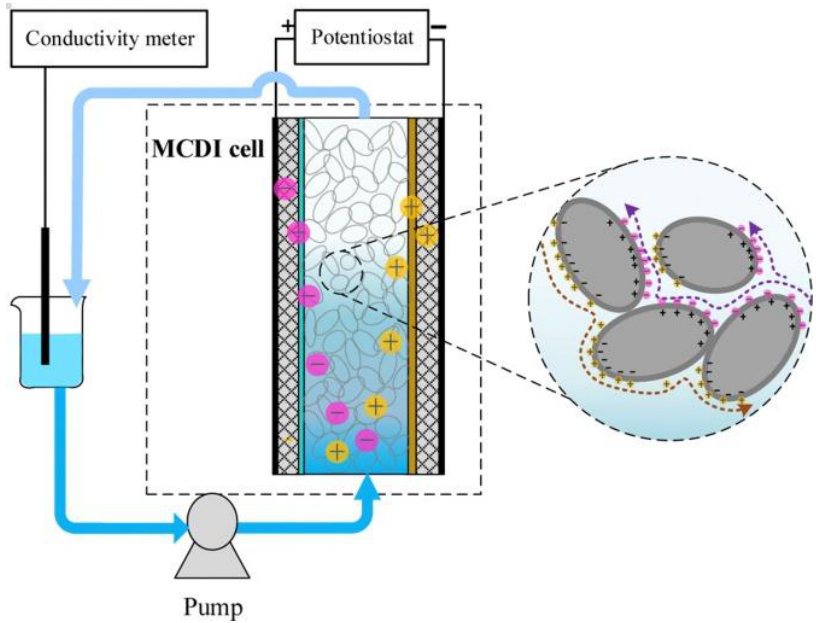
Figure 8. Schematic diagram of GAC (granular activated carbon)-MCDI as depicted by Bian et al. [124]. Reproduced with permission, copyright Elsvier, 2015.